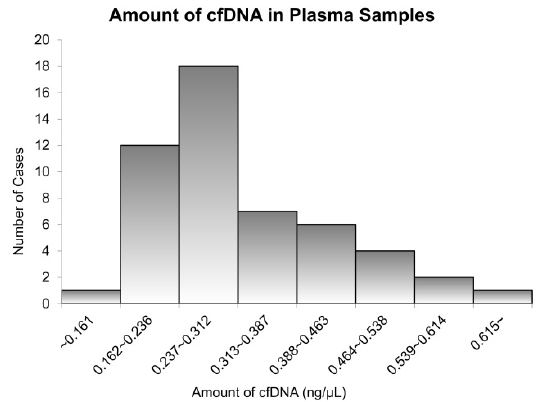
Figure 4. The relationship between the number of cases and cell-free DNA (cfDNA) concentration. The x -axis shows various concentrations of cfDNA, and Y -axis presents the number of cases. The median concentration of cfDNA extracted from plasma samples was 45.92 ng/ μ L, the minimum concentration was 25.76 ng/ μ L, and the maximum concentration was 110.24 ng/ μ L.